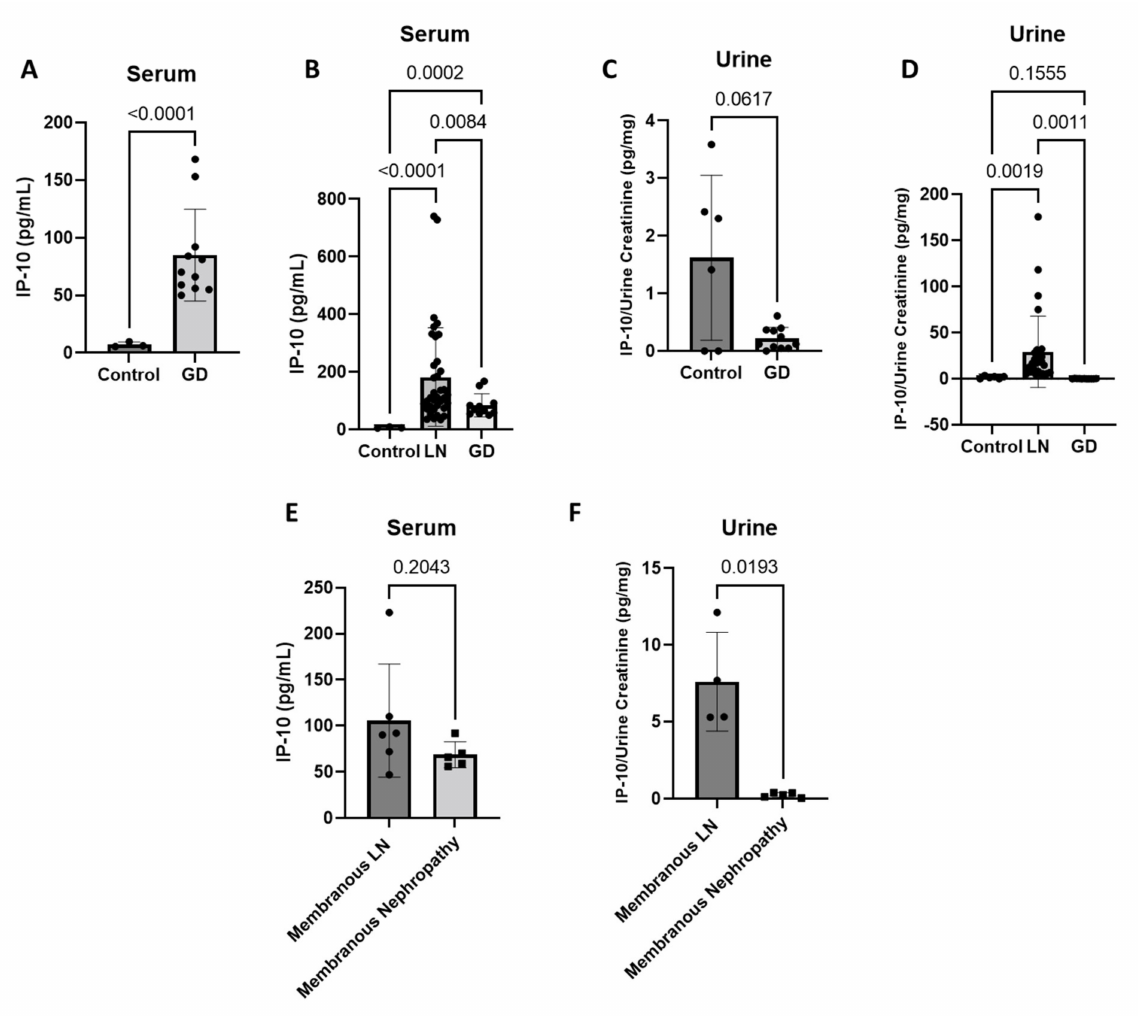
Figure 3. Urine IP-10 is increased in LN patients versus non-LN glomerular diseases (GD) and Membranous LN compared with primary Membranous Nephropathy. ( A ) GD serum compared to healthy individuals (control) ( n = 3, n = 11; Two-Tailed T-Test with Welch’s correction); and ( B ) serum IP-10 is significantly increased in LN compared to the GD cohort, and both cohorts’ serum IP-10 levels are significantly increased compared to control ( n = 3, n = 36, n = 11; Correction Brown–Forsythe and Welch ANOVA Test, multiple comparisons); ( C ) IP-10 urine levels are not significantly different in GD compared to control ( n = 6, n = 11; Two-Tailed T-Test with Welch’s correction); and ( D ) in urine, IP-10 is significantly increased in LN compared to GD and control where GD is similar to control levels ( n = 6, n = 29, n = 11; correction, Brown-Forsythe and Welch ANOVA Test, multiple comparisons); ( E ) patients with pure Membranous LN have similar serum IP-10 levels compared to patients with primary Membranous Nephropathy ( n = 6, n = 5; Two-Tailed T-Test with Welch’s correction); and ( F ) patients with pure Membranous LN have increased urine IP-10 levels compared to patients with primary Membranous Nephropathy ( n = 4, n = 5; Two-Tailed T-Test with Welch’s